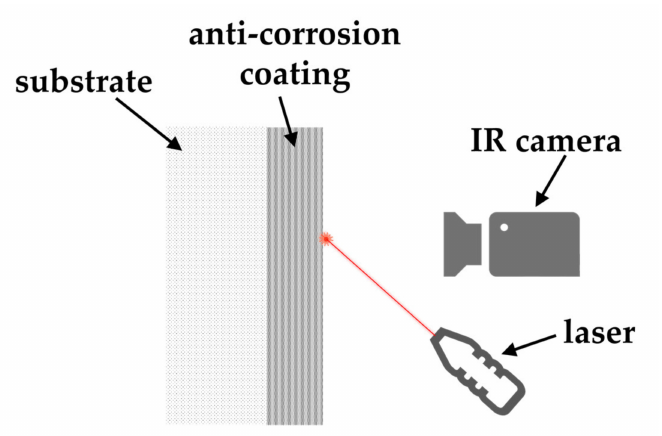
Figure 2. Experimental setup of in-plane and in-depth thermal diffusivity measurement.